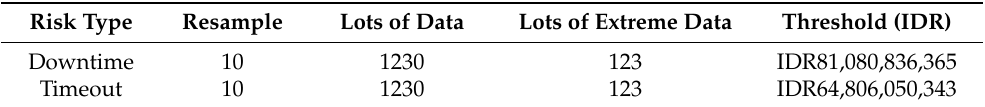
Table 2. The summary results of the MEBoot processed